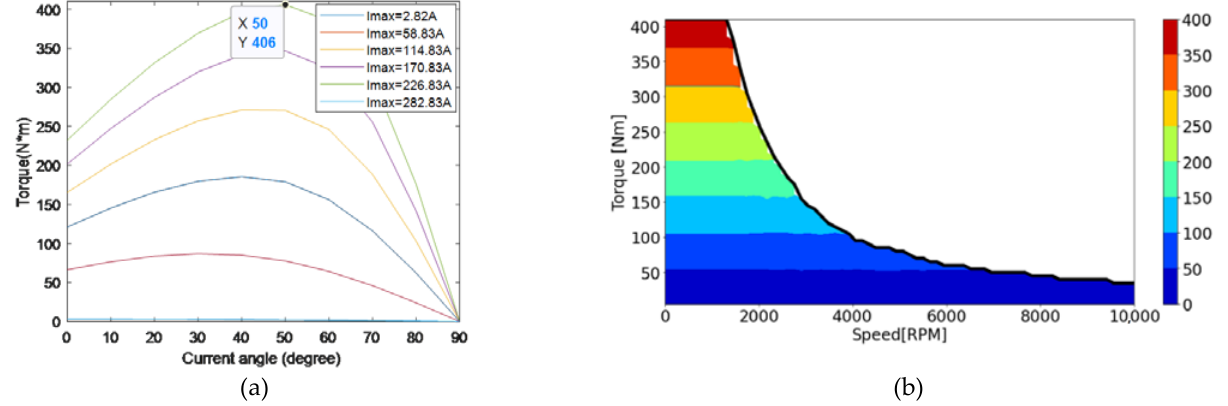
Figure 7. Analyzed motor torque: ( a ) torque-current angle; ( b ) torque-speed map.